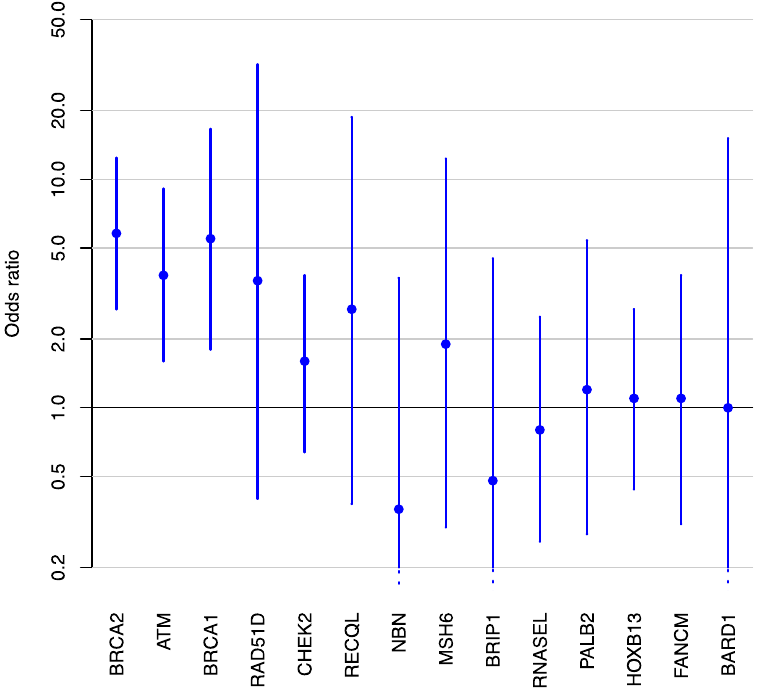
Figure 1. Adjusted odds ratios (large dots) and corresponding 95% confidence intervals (vertical lines) for the association between aggressive prostate cancer and germline pathogenic variants in various genes, sorted by p -value.